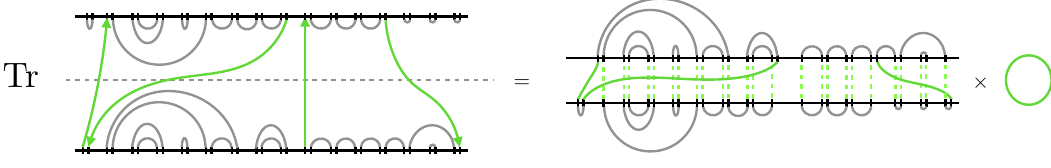
) . We have included a D ( k 1 # t k − 1 2 H ⊗ 2 n χ